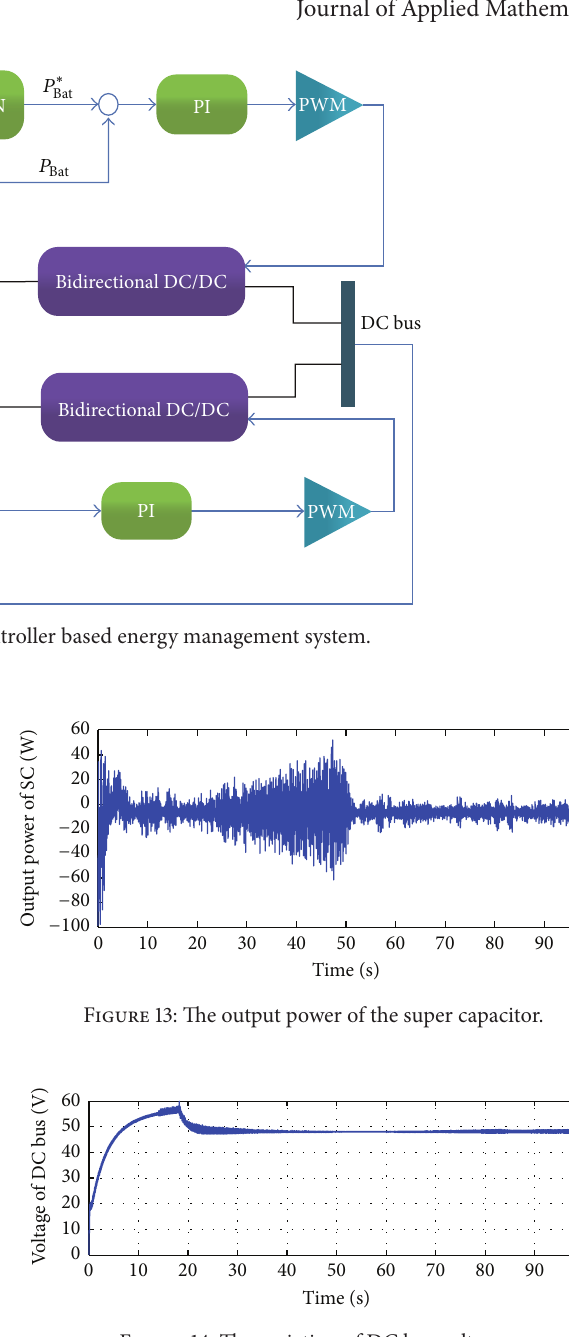
Figure 14: The variation of DC bus